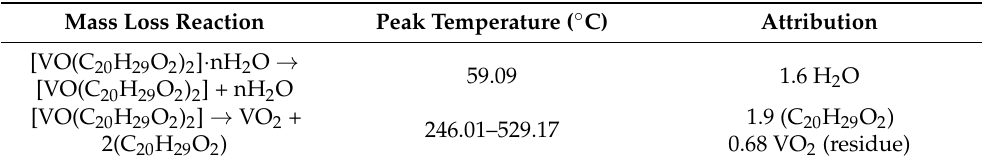
Figure 3. Thermal decomposition curve (TG/DTG) of VO(IV)- bis (abietate). Conditions: 5 mg mass; compressed air atmosphere (20 mL s − 1 ); 10 °C s − 1 ramp; temperature of 30–1000 °C; alumina pan. Table 1. Analytical data due to thermal decomposition (TG/DTA) of VO(IV)- bis (abietate) with a tentative